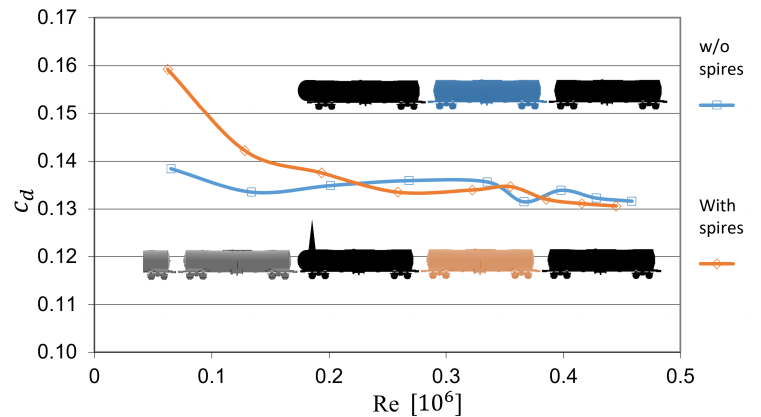
Figure 5. Baseline drag coefficient of test wagon versus Reynolds number. Blueline : Simulation of tank wagon position near the train head; Orange line : Simulation of tank wagon position near the train